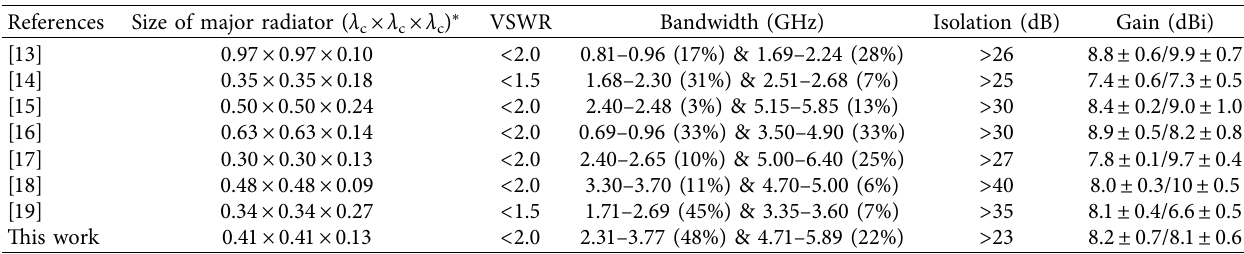
Figure 9: Simulated and measured radiation patterns of the proposed antenna at (a) 2.6GHz, (b) 3.5GHz, and (c) 4.8GHz. Table 2: Comparison with dual-band base station